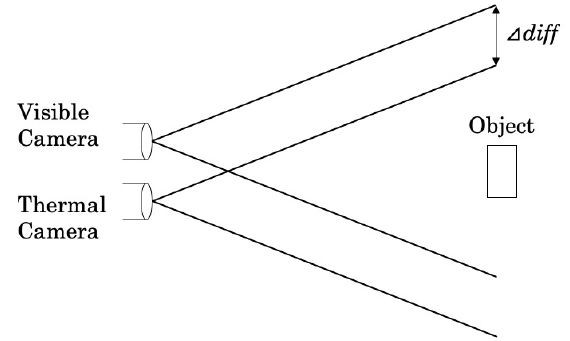
Figure 2. Position difference of visible and thermal